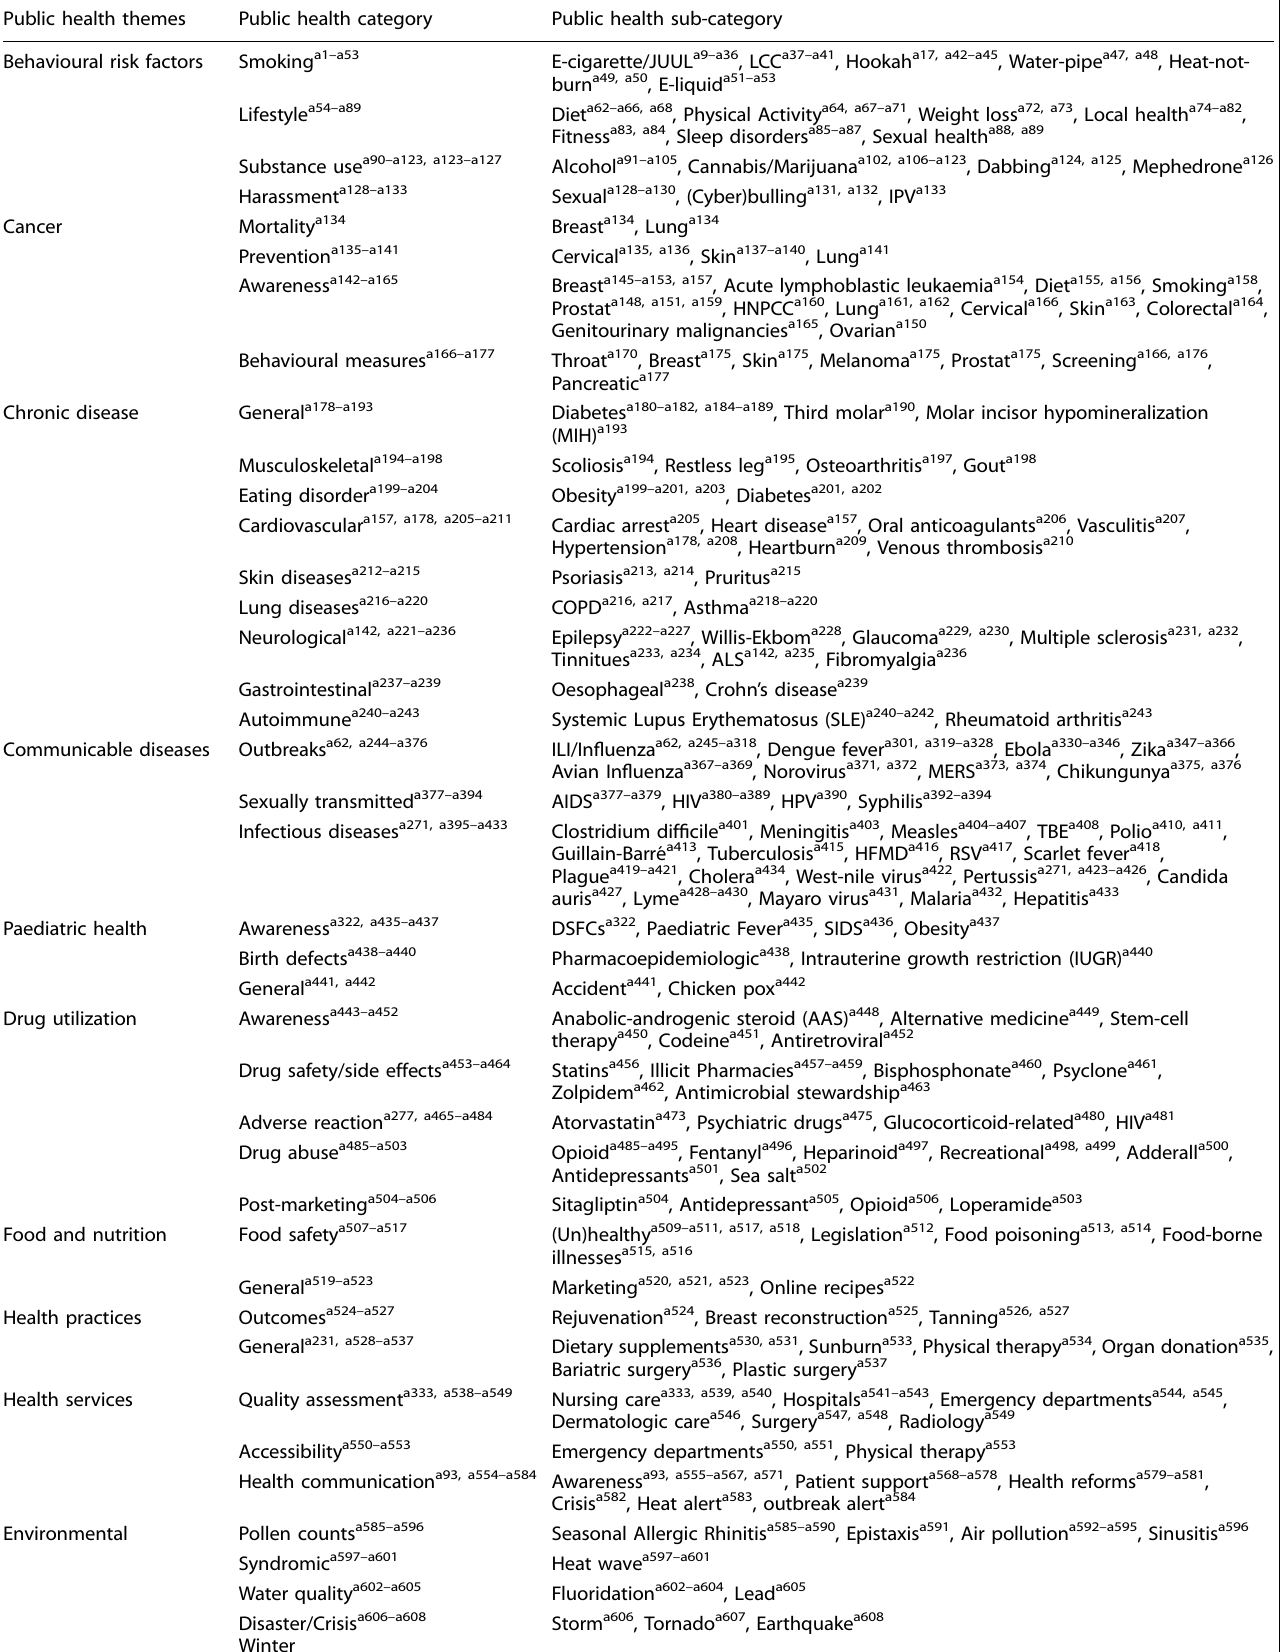
Table 1. The hierarchy of public health-related themes studies by the included articles in this